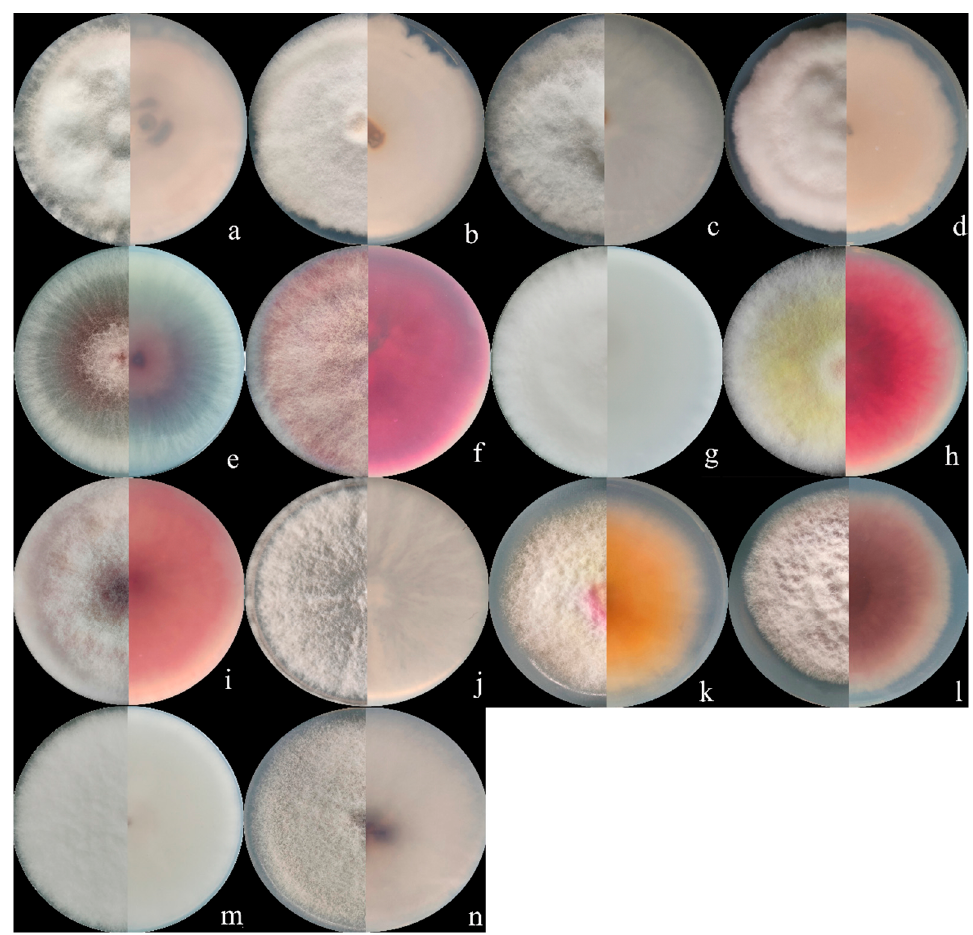
Figure 2. Colony appearance of representative isolates of 14 Fusarium species. ( a ) F. compactum ; ( b ) F. ipomoeae ; ( c ) F. citri ; ( d ) F. flagelliforme ; ( e ) F. verticillioides ( f ) F. sporotrichioides ; ( g ) F. armeniacum ; ( h ) F. asiaticum ; ( i ) F. graminearum ; ( j ) Fusarium sp.; ( k ) F. acuminatum ; ( l ) F. glycines ; ( m ) F. annulatum ; ( n ) F. temperatum .